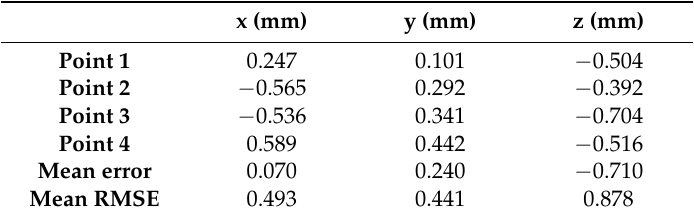
Table 2. Average error for the 3D position of four control points.